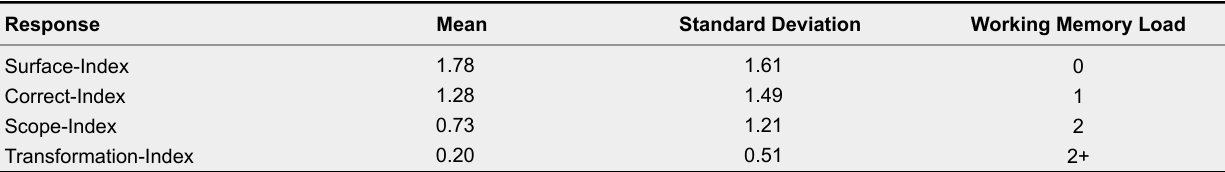
Response Pattern for DeMorgan´s Law 2